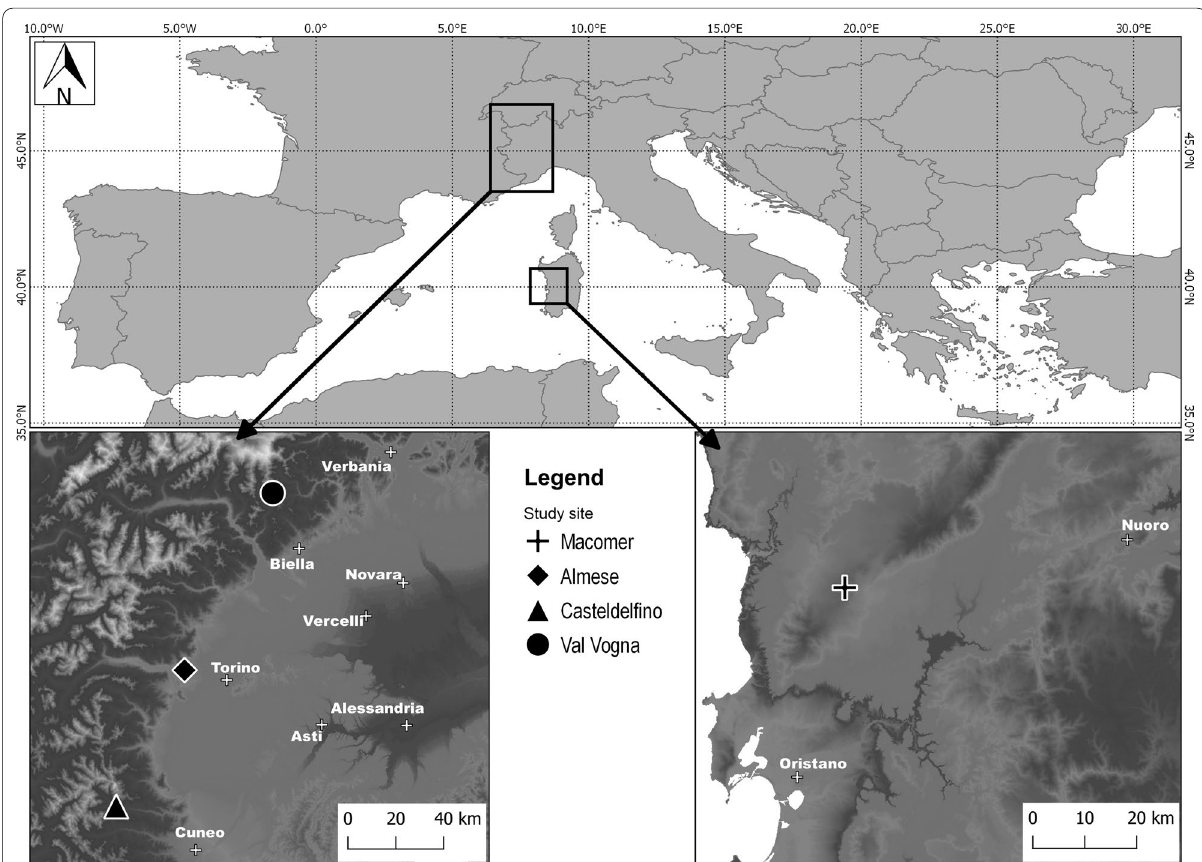
Fig. 1 Map of the four study sites in Italy. Each site is in a specific biogeographic region: Mediterranean (Macomer), Continental (Almese), and Alpine (Casteldelfino and Val